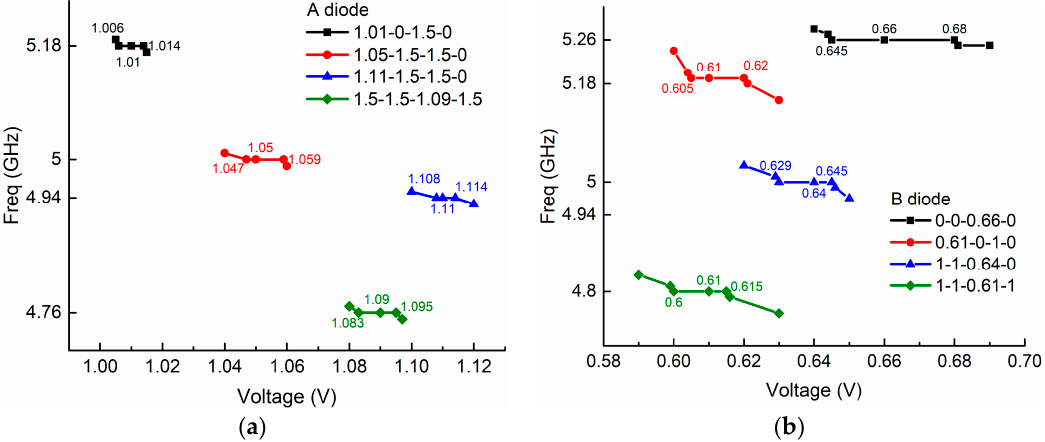
Figure 13. The supplying voltage tolerance of nonlinear states of ( a ) PIN diode A ( b ) PIN diode B.